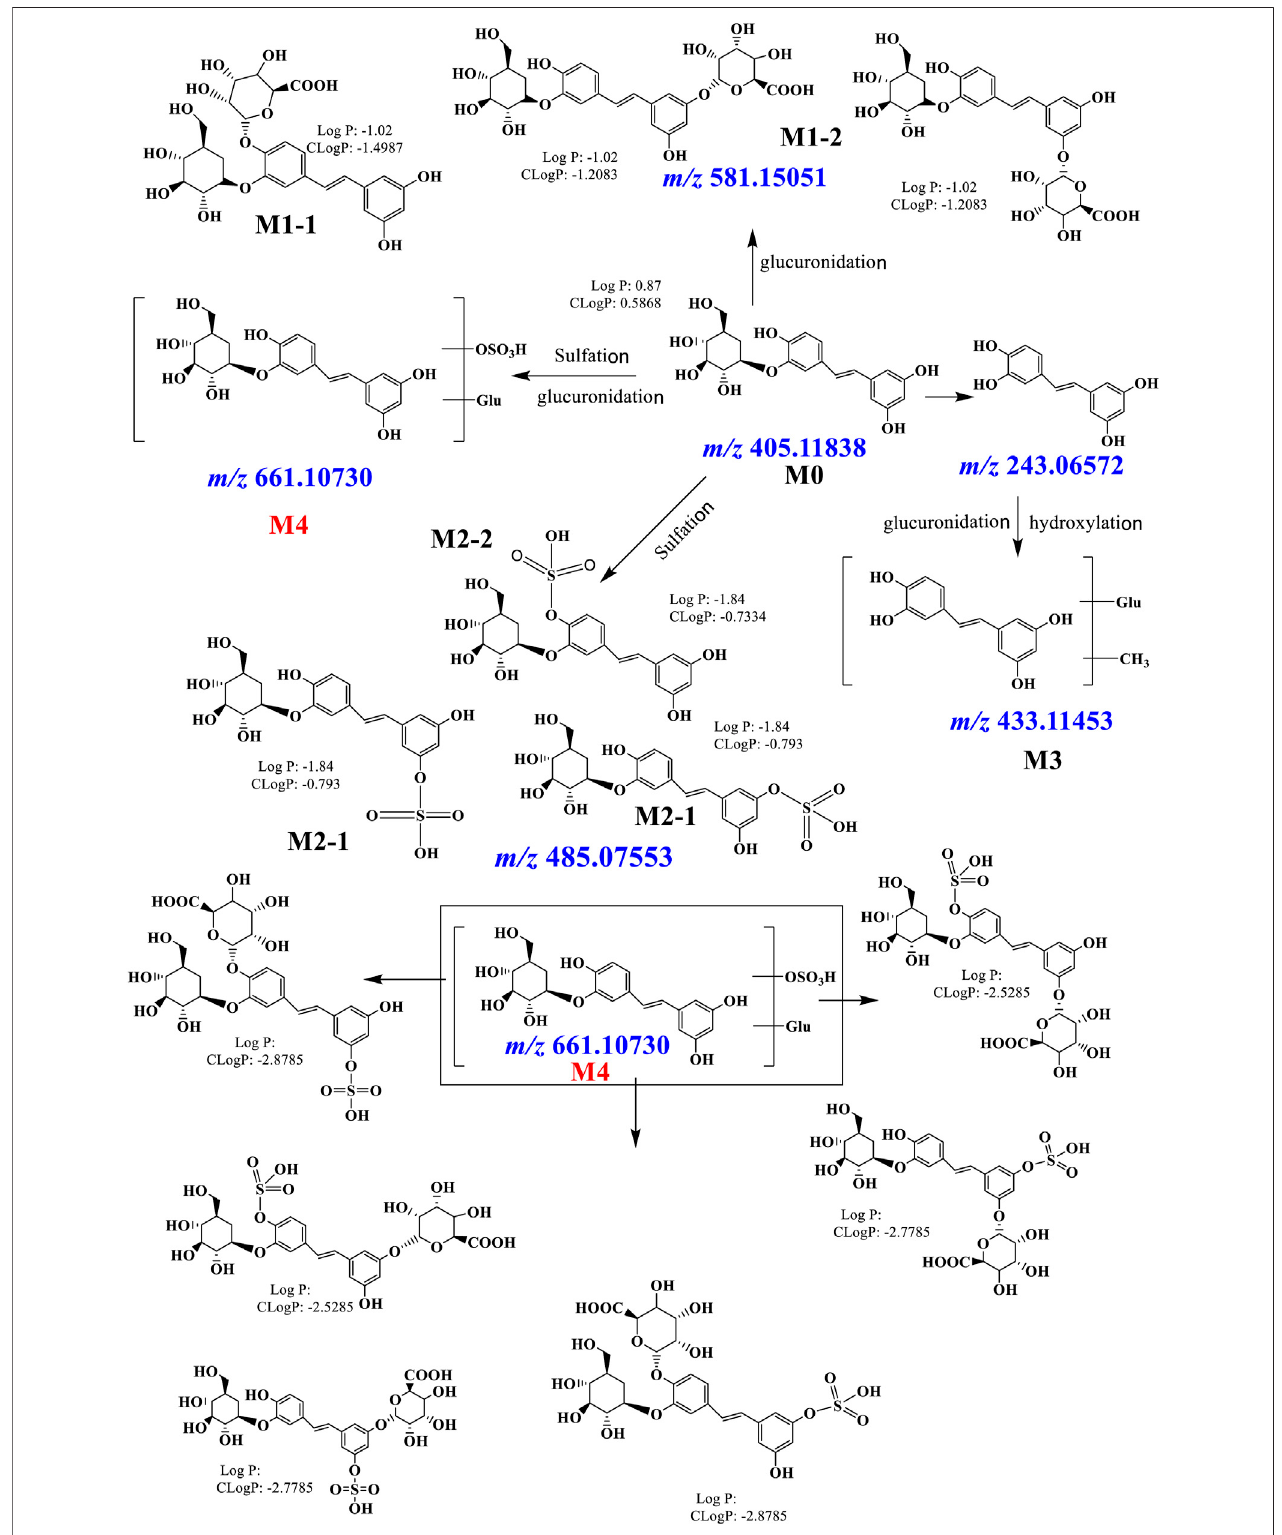
FIGURE 5 | Possible metabolic pathways of PG in vivo .